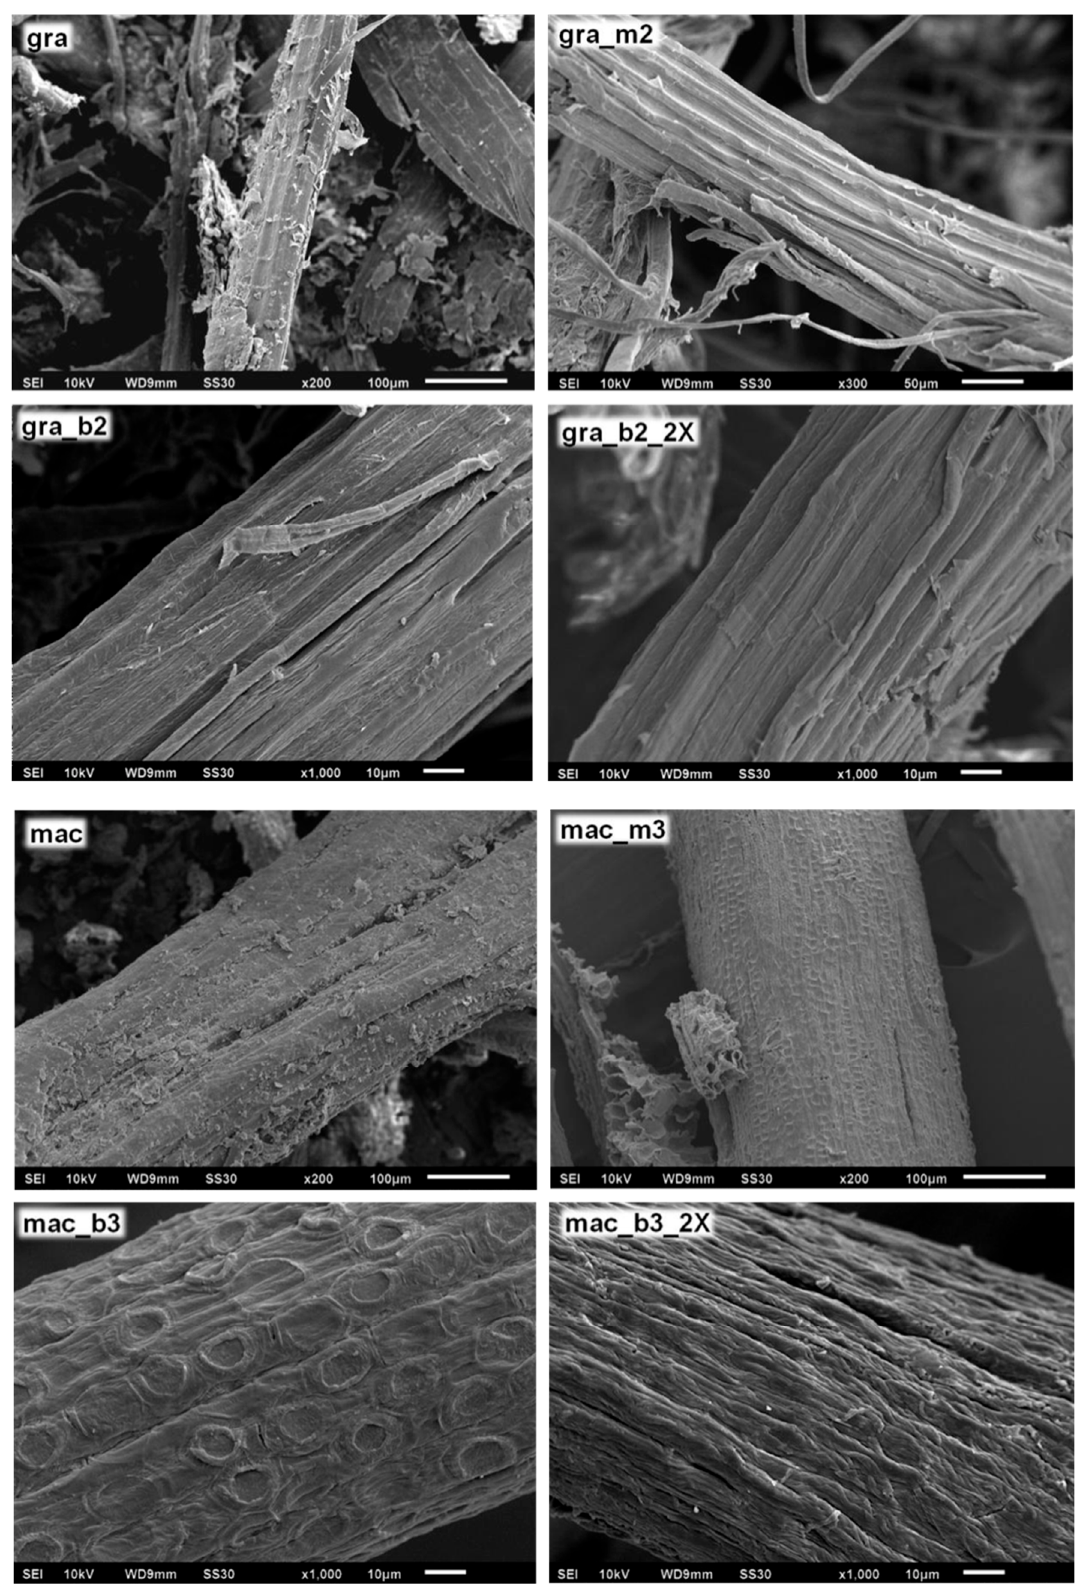
Figure 6. SEM micrographs of the surfaces of raw, mercerized and bleached fibers of gravata (gra) and macauba (mac) .